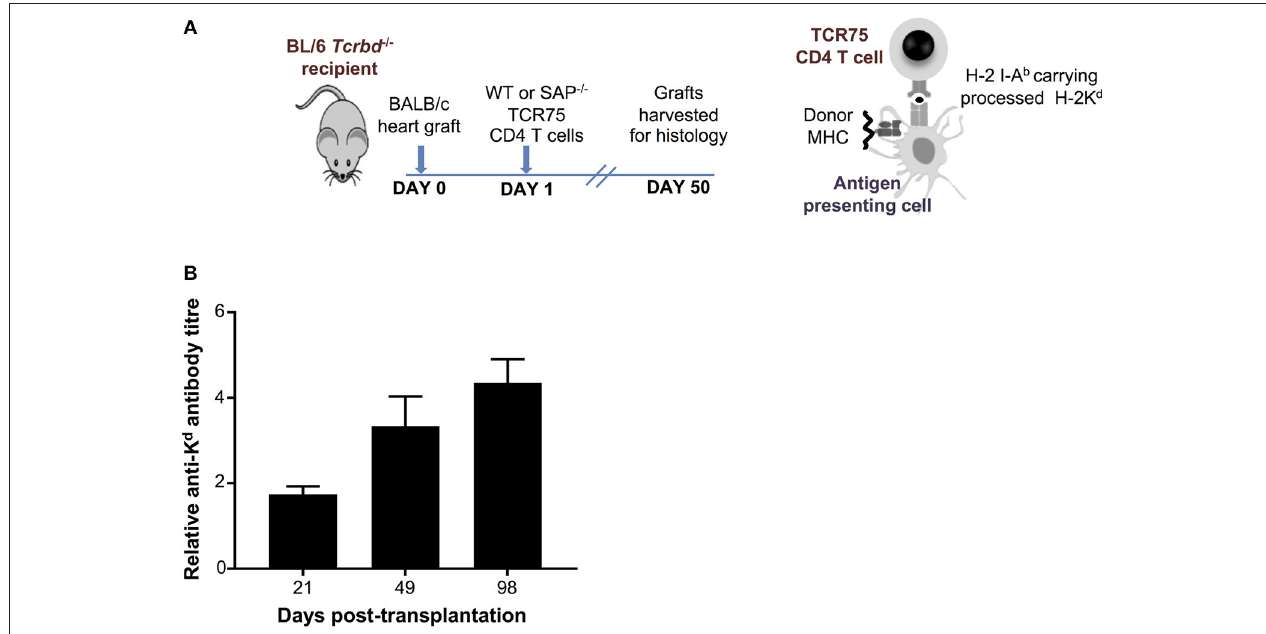
FIGURE 1 | Development and characterization of murine model of antibody-mediated heart allograft rejection. (A) Figure is adapted from our companion paper (4). BL/6 Tcrbd − / − recipients of BALB/c heart allografts were either unmodified (no cells group) or reconstituted the day after with either wild-type or SAP-deficient CD4T cells from TCR transgenic Rag1 − / − TCR75 animals that recognize I-A b -restricted H-2K d 54 − 68 peptide. (B) ELISA assays of serum samples obtained from BL/6 Tcrbd − / − recipients of BALB/c hearts and reconstituted with 10 3 TCR75 CD4T cells ( n = 4) shows progressive increase of anti-H-2K d IgG alloantibody until day 100.